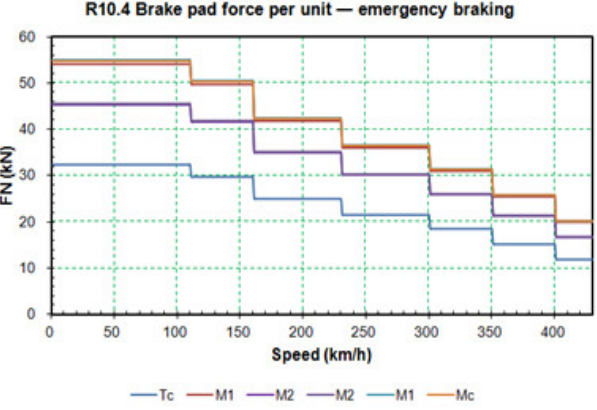
Figure 9. Clamping force design specifications for emergency braking for the HEMU-430X.